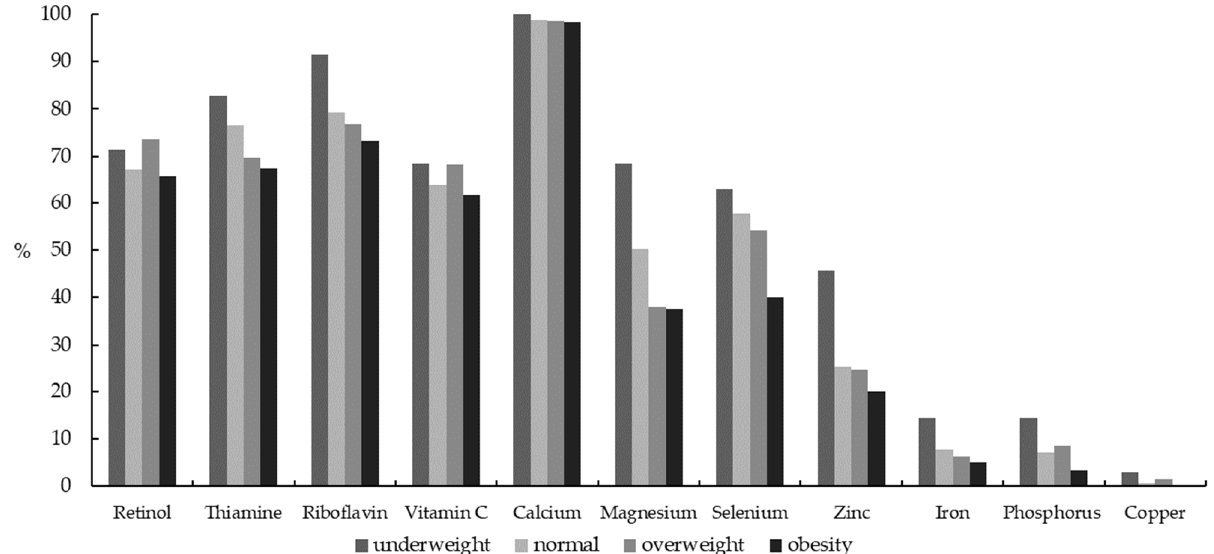
Figure 1. Percentage of Chinese boys aged 6–17 years with dietary micronutrient intakes below the estimated average requirements (EARs) by body weight status.